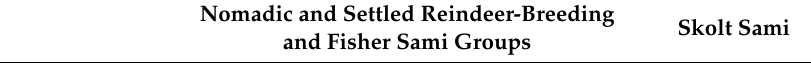
Table 3. Percentage contribution of different foodstuffs to total energy in families of different Sami groups [25].